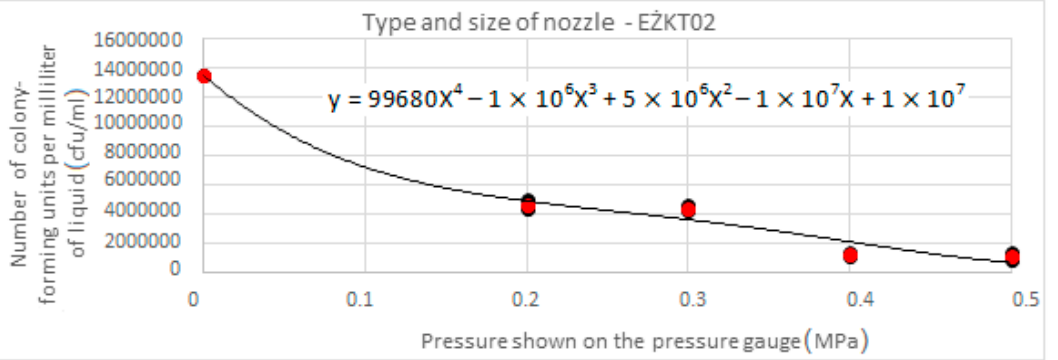
Figure 7. The influence of pressure on survival of cfu/mL of liquid for E Ż K06.